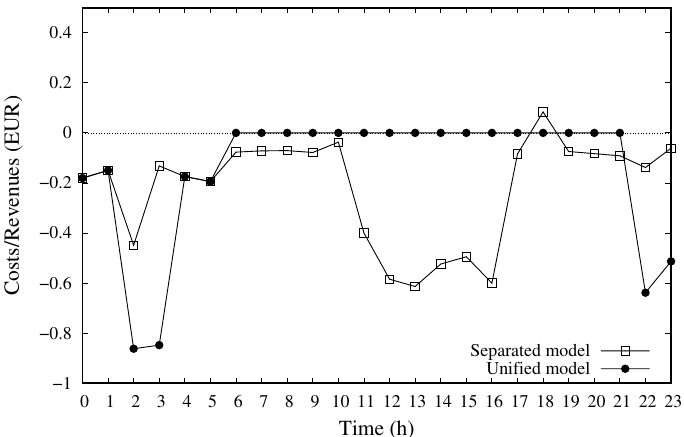
Figure 7. Daily cost/saving for Separated and Unified